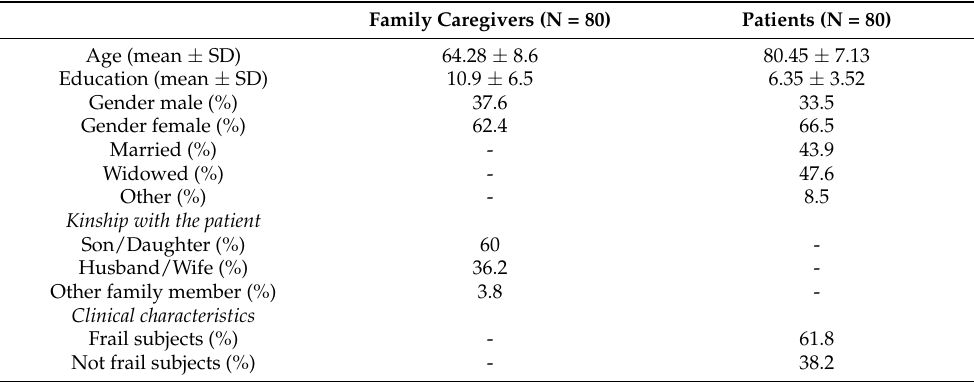
Table 1. Main characteristics of the